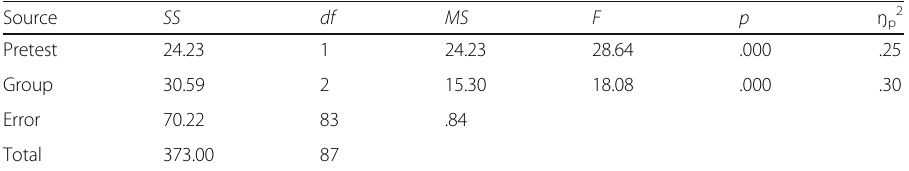
Table 14 Results of one-way ANCOVA for timed grammaticality judgment test Source SS df MS F p ŋ p 2 Pretest 24.23 Group 30.59 Error 70.22 Total